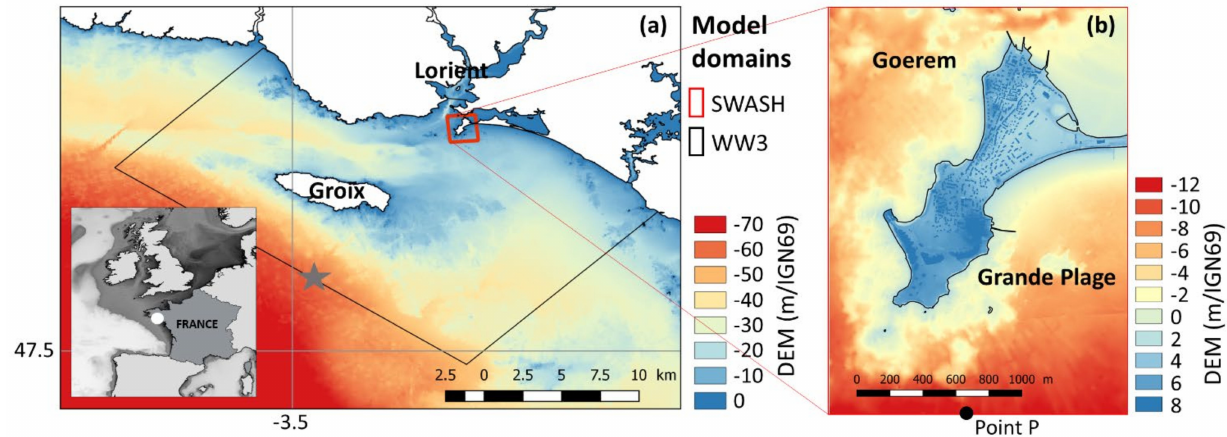
Figure 1. Location and topo-bathymetry of the study site ( a , b ) and computational domains of the models (WW3 and SWASH) in the modelling chain ( a ). The star indicates the location of the offshore wave forcing. Panel ( b ) is adapted from Idier et al. (2020c) and updated (the local DEM, DEM2008, was replaced by DEM2015–2018, see Section 2.4).